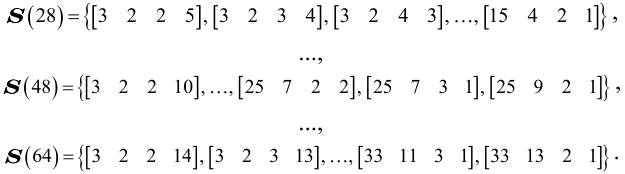
VIII. CNN B EST P ERFORMANCE AT A S UBSEQUENCE OF F ILTER S PATIAL E XTENTS Each of those 19 databases contains 52,000 N N  images of EEACLs. According to (5), nearly 70 % of images are used in training and 15 % of them are used in validating while training. The training consists of four epochs. The CNN is validated at each epoch. Thus, the CNN performance for the filter set (17) is represented with a four-element validation